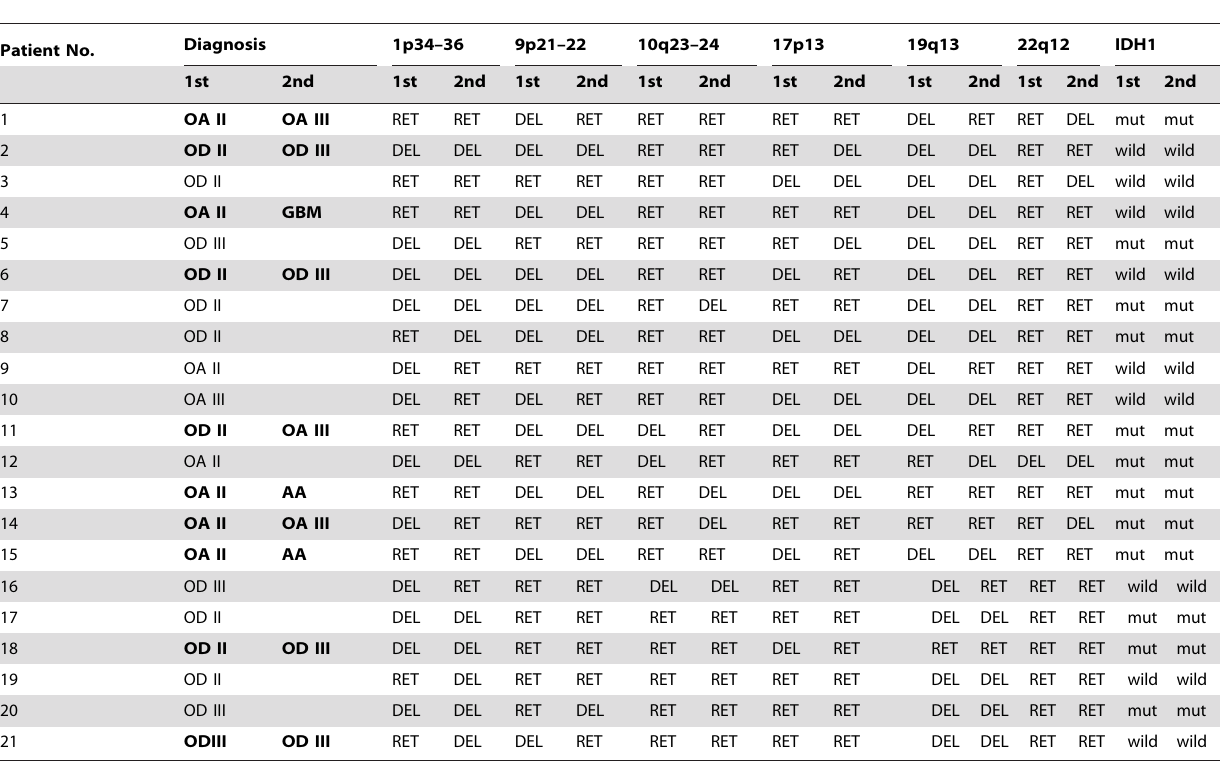
Table 3. Genetic analysis in longitudinal samples a .